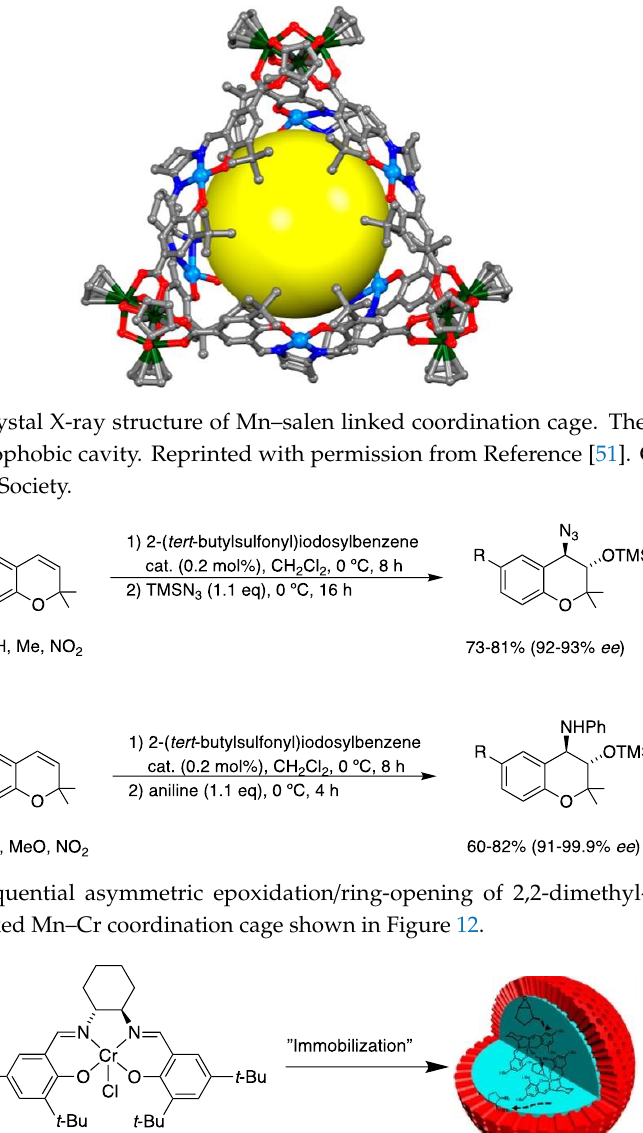
Figure 12. Single crystal X-ray structure of Mn–salen linked coordination cage. The yellow sphere highlights the hydrophobic cavity. Reprinted with permission from Reference [51]. Copyright 2018 American Chemical Society.